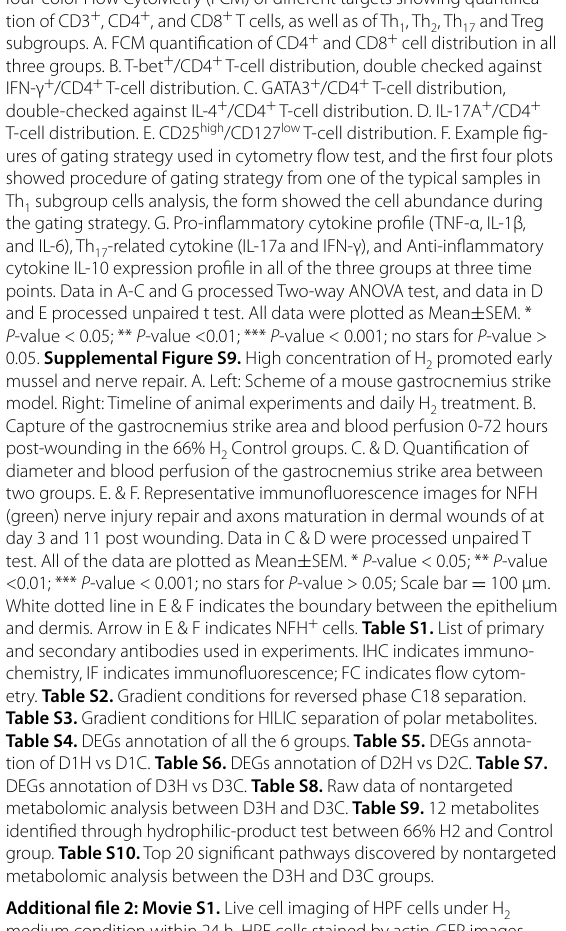
Table S3. Gradient conditions for HILIC separation of polar metabolites. Table S4. DEGs annotation of all the 6 groups. Table S5. DEGs annota- tion of D1H vs D1C. Table S6. DEGs annotation of D2H vs D2C. Table S7. DEGs annotation of D3H vs D3C. Table S8. Raw data of